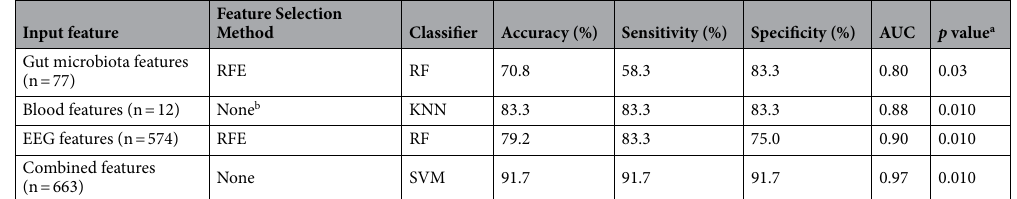
Table 2. Classification performance of the optimal model including different input features using the integrated machine learning framework (tenfold). AUC area under the receiver operating characteristic curve, RFE recursive feature elimination, KNN k-nearest neighbor, LR logistic regression, RF random forest, SVM support vector machine, EEG electroencephalogram. a The statistical significance of the permutation test was set to p < 0.05. b None means no feature selection algorithm was used.